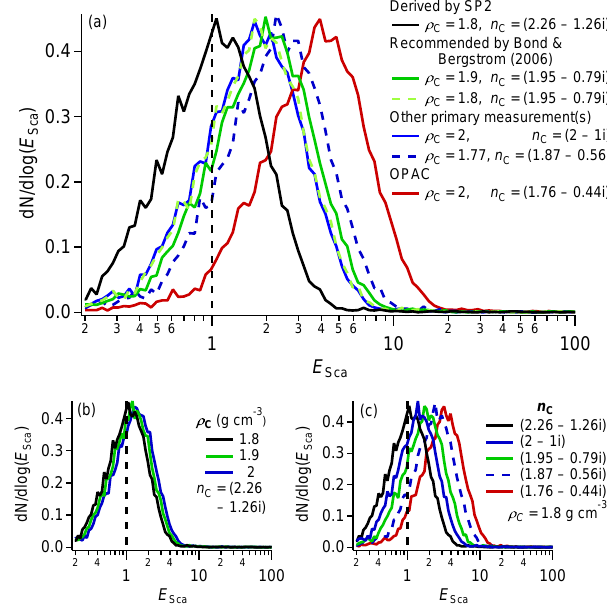
Figure 5. Normalized E Sca distribution, in arbitrary units, for the least coated particles (thermodenuder >220 ◦ C and − log ( NO x / NO y ) <10th percentile) for different rBC core densi- ties and refractive indices. Panel (a) shows data for density (in units of gcm − 3 ) and refractive index combinations used in previous SP2 core / shell modelling, whilst panels (b) and (c) illustrate the sensi- tivity to core density and refractive index